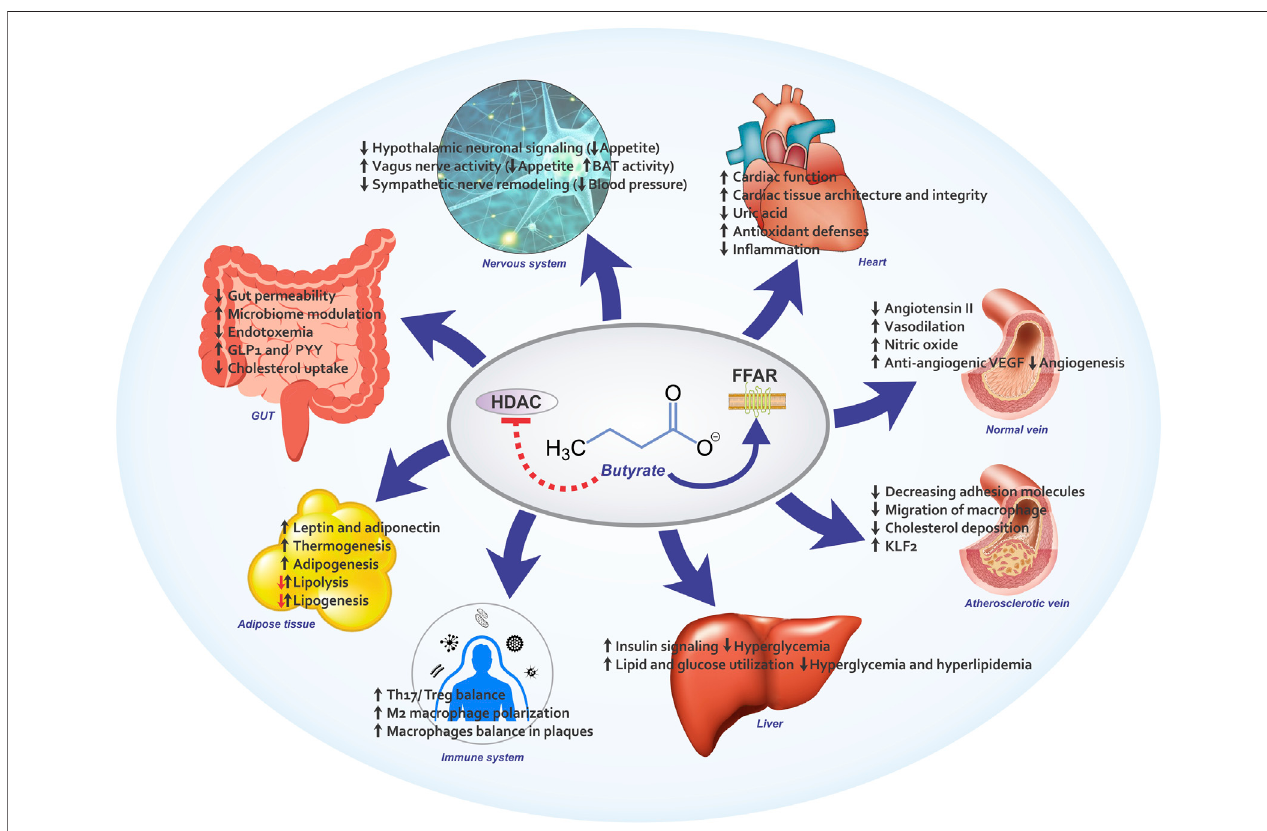
FIGURE 2 | An overview of butyrate ’ s protective effects in CVD and CVD risk factors. FFAR: free fatty acid receptor, HDAC: Histone deacetylase, KLF2: Kruppel Like Factor 2,VEGF: vascular endothelial growth factor, GLP-1: glucagon-like peptide 1, PYY, peptide YY.